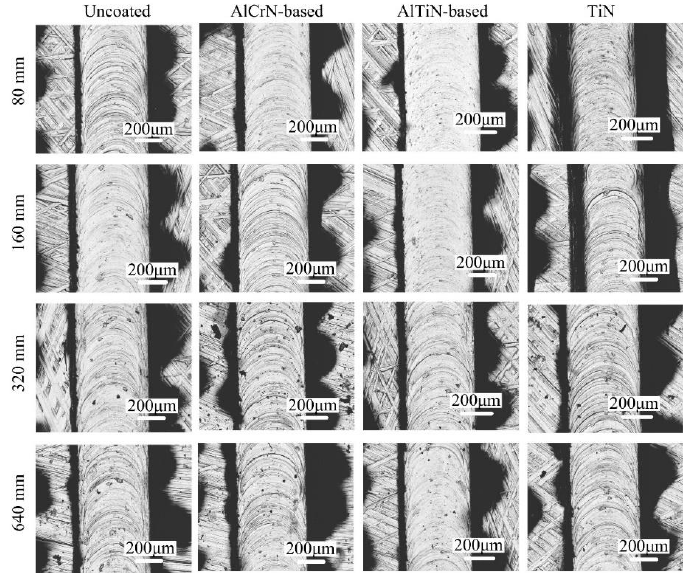
Figure 7. Surface morphologies of microgrooves machined with coated micro end mills.